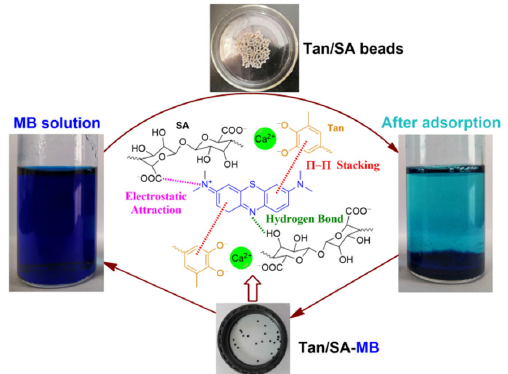
Figure 1. Bio ‐ based Tan/SA hydrogel absorbent for the removal of